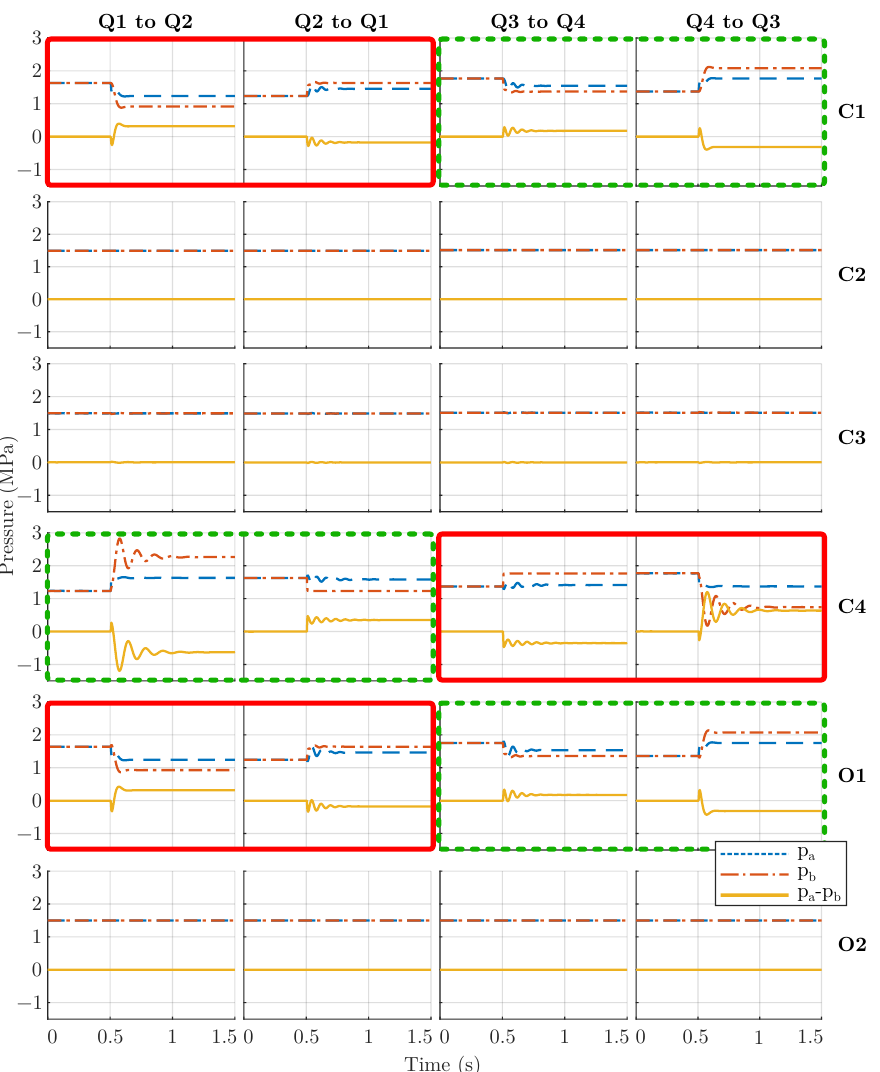
Figure 13. Switch without pressure feedback between different quadrants for different configurations. The forced mode-switch occurs after 0.5 seconds. The cases with negative pressure-drop hysteresis are marked with solid red lines and the ones with positive are marked with dashed green